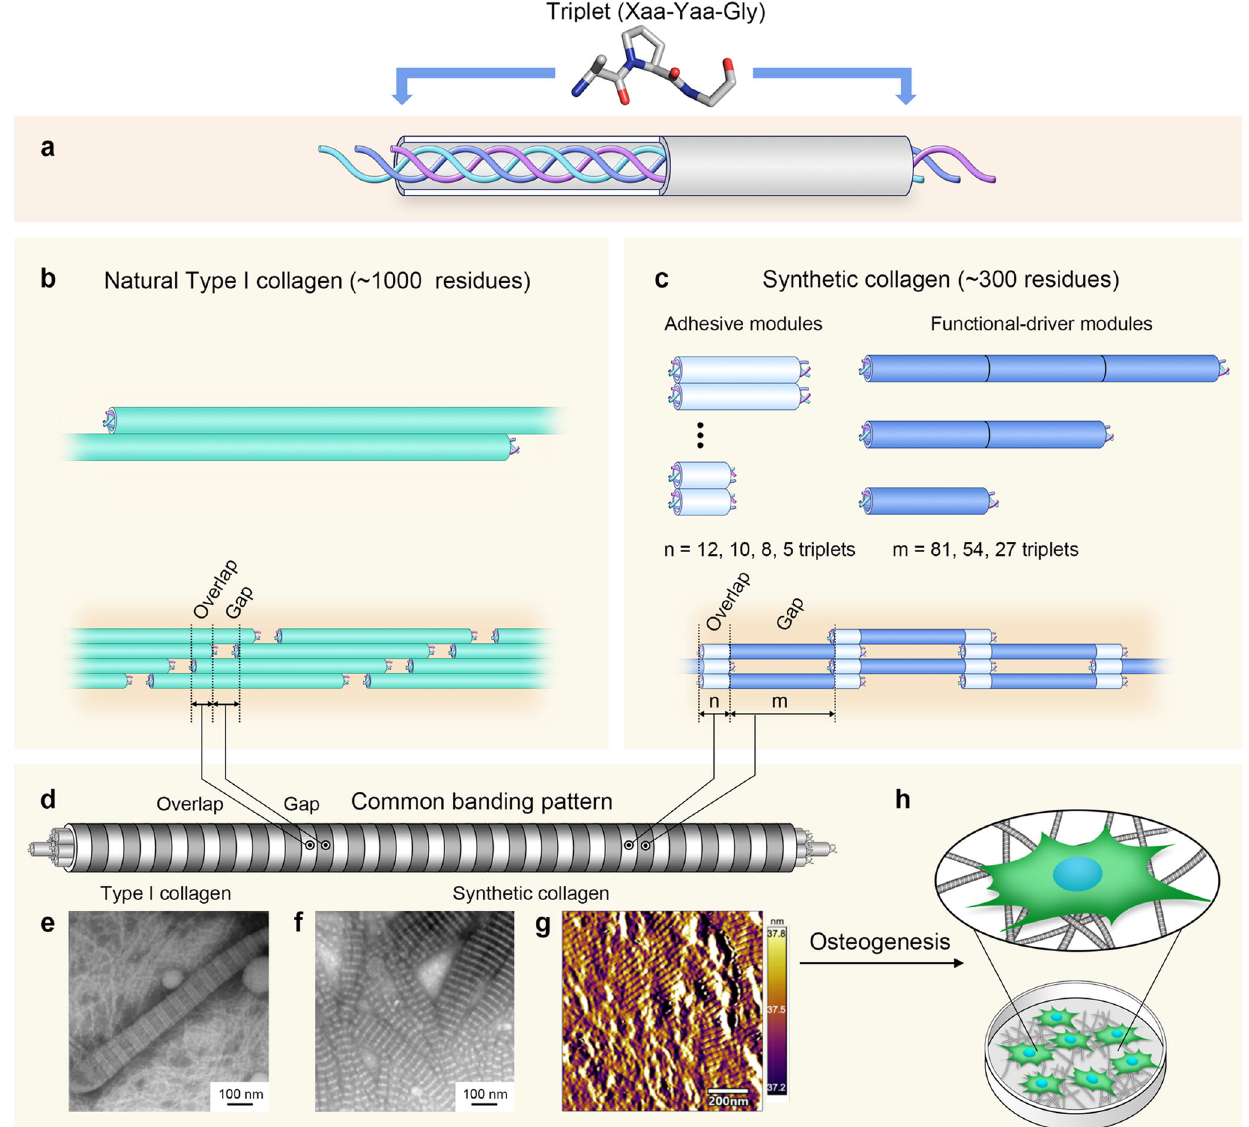
Fig. 1 | Assembly hierarchy of synthetic collagens built with a modular design strategy vs. natural Type I collagen. a The folded unit of collagen is the triple- helix, consisting of three supercoiled polypeptide chains with repeating Xaa-Yaa- Gly triplets. b In natural Type I collagen, thousands to millions of long thin triple- helices (~1000 residues per chain, diameter ~1nm, length ~300nm) are offset and packed in parallel to form fi bers 9 . Type I collagen folding and supramolecular assembly have been extensively reviewed elsewhere 60 . c Our synthetic collagens were engineered with two adhesives (white) modules fl anking a functional-driver (blue)module.Adhesivemoduleswereeitherhydrophobic,consistingof n Pro-Pro- Gly triplets on both ends of functional-driver modules, or electrostatic, consisting of n Pro-Arg-GlytripletspositionedN-terminaltothefunctional-drivermodule,and with the same number of Glu-Pro-Gly triplets at the C-terminal end. Sequences of the functional-driver modules were based on fragments of length m from the Scl2